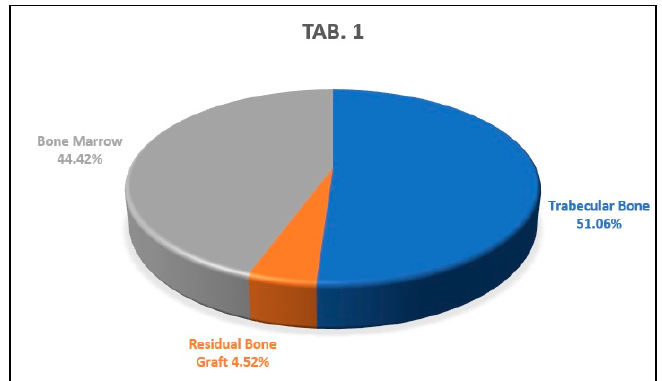
Figure 11. Two-dimensional (2D) reconstruction of the bone sample after staining with Hematoxylin and Eosin staining solution (magnification 25×, scale bar 400 µm). Bone trabeculae are dark-pink colored (#), whereas graft material appears light-pink colored (*). Three serial sections of the sample were analyzed, taken in the coronal part, in the middle part, and in the apical part of the sample. From the analysis of the first histological section, we found that the percentages of newly formed bone, residual biomaterial, and bone marrow were, respectively, 51.06%, 4.52% and 44.42% (Figure 12).